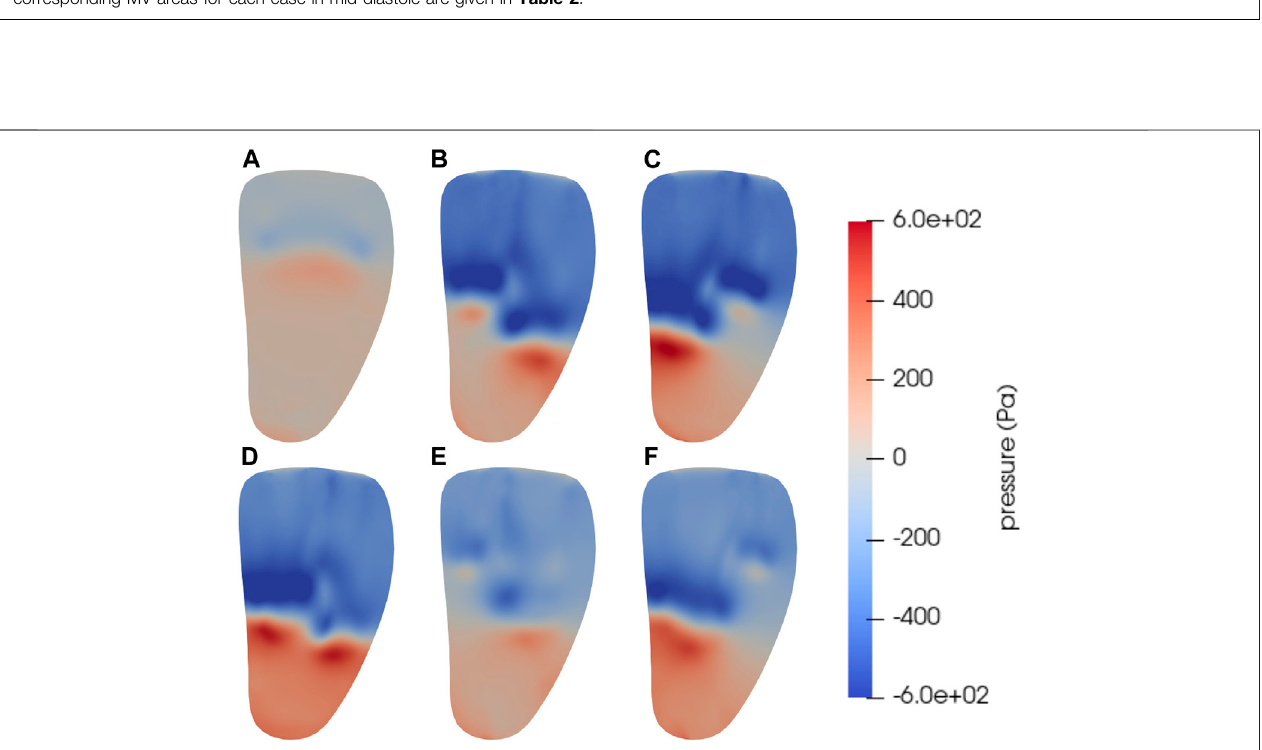
FIGURE 4 | Snapshots of the pressure at time t = 0.45 s in a vertical bicommissural cut through the left ventricle. This is in early diastole before the E-wave peak, whentheintraventricularblood fl owisdominatedbystrongin fl owjets.Theregionsjustbelowthejetsexperiencehighpressure,whilethereisapressuredroparoundthe base of the jet. (A) shows the untreated case. The other sub fi gures have MVC ’ s positioned at s · l from the center, with l being the long axis of the MV model. The scale factor s forthedifferentcasesare (B) s = − 0.2, (C) s =0.2, (D) s =0.0, (E) s = − 0.4, (F) s